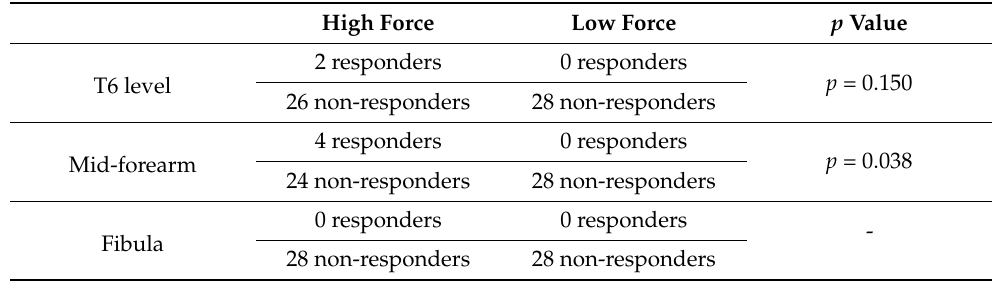
Table 2. X 2 = Chi-square analysis based on minimal detectable change (MDC). Number of responders ( n =